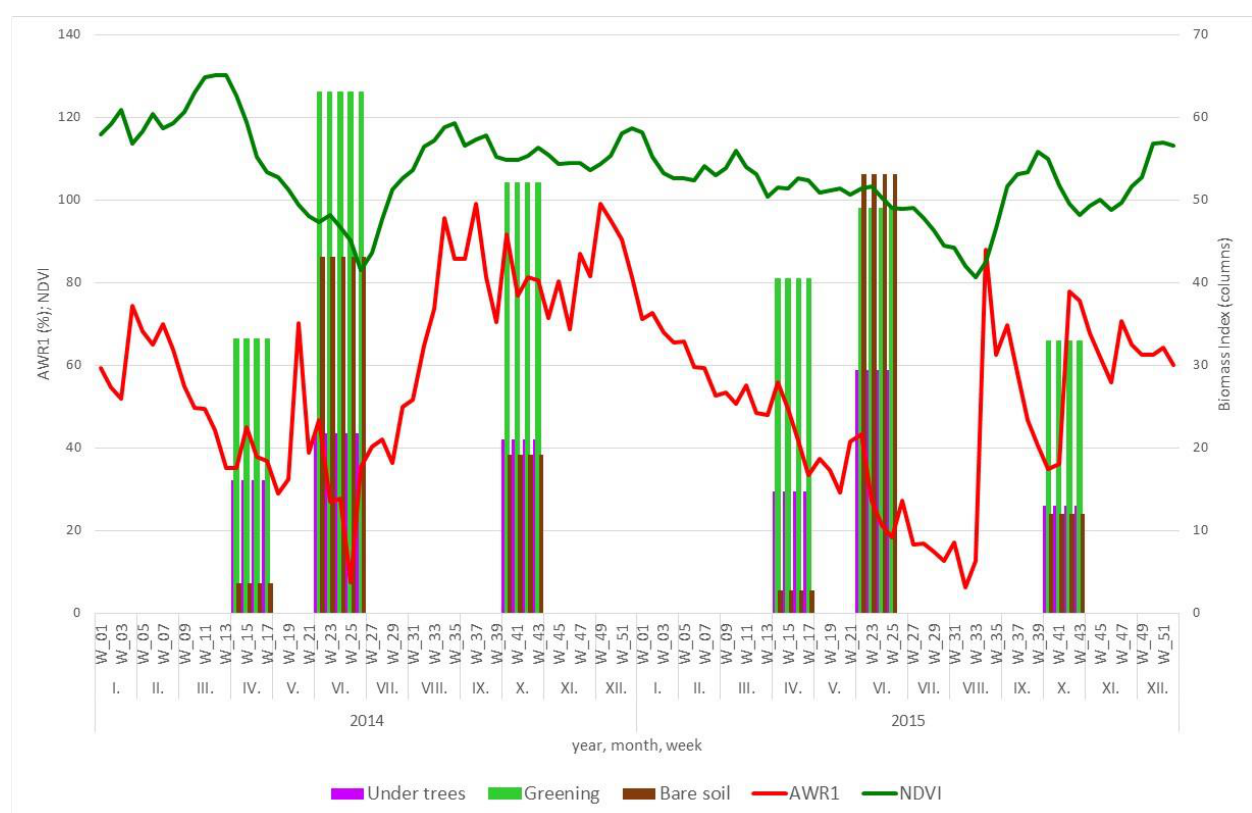
Figure 6. Development of AWR1, NDVI, and biomass index in the orchard.